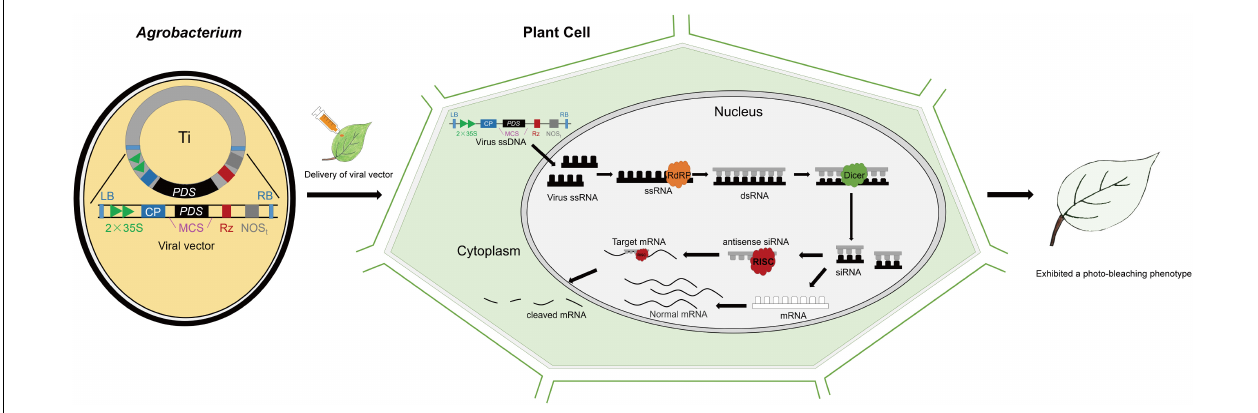
FIGURE 1 | Virus-induced gene silencing (VIGS) mechanism. Phytoene desaturase ( PDS ) serves as an example. Upon infection, the T-DNA carrying the viral genome is transformed into the plant by Agrobacterium and then transcribed by the host’s RNA polymerase. RNA-dependent RNA Polymerase (RdRP) (yellow) produces double-stranded RNA (dsRNA) from the single-stranded RNA (ssRNA) viral transcript. The dsRNA is then recognized by DICER-like enzyme, Dicer (green) and cleaved into short interfering RNAs (siRNAs). Antisense siRNAs are recognized by RNA-induced silencing complex, RISC (red) and melted into ssRNAs, which then serve as templates for target gene degradation. The single-stranded siRNAs are amplified and spread as mobile silencing signals throughout the plant, thus resulting in target gene silencing in plant organs distant from the site of infection, symbolized by the photo-bleaching phenotype of the entire leaf. LB: left border; RB: right border; 2 × 35S: duplicated cauliflower mosaic virus 35S promoter; CP: coat protein; MCS: multiple cloning site; PDS : PDS cDNA fragment; Rz: self-cleaving ribozyme;